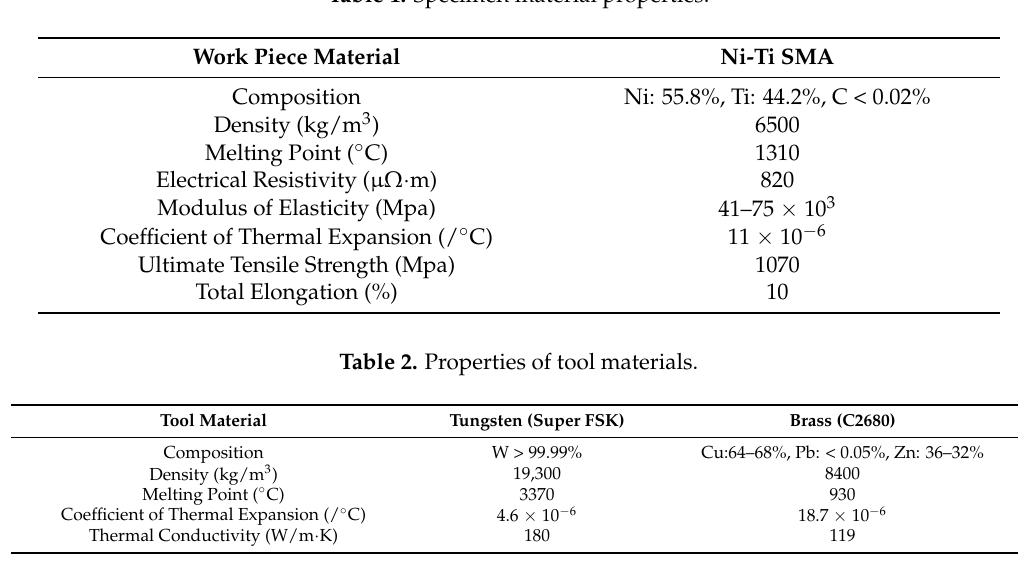
Table 1. Specimen material properties.